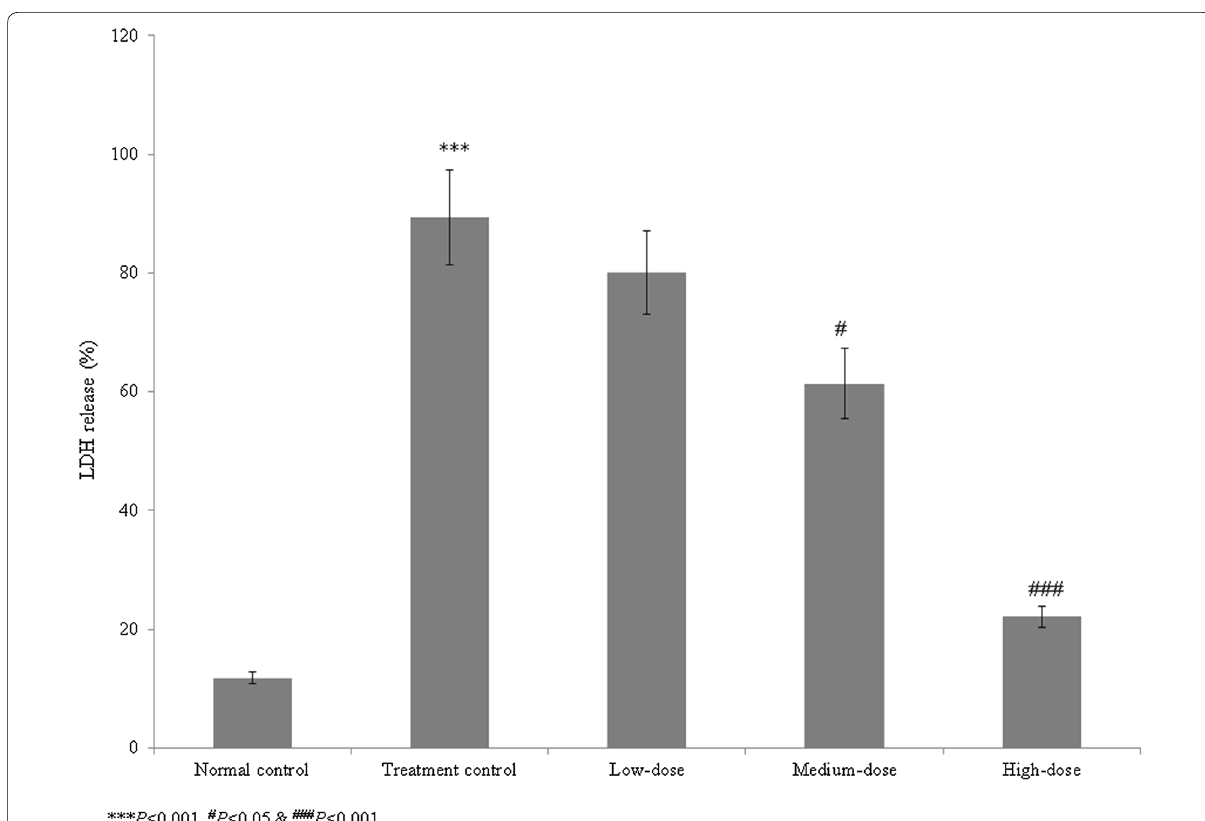
Fig. 2 Effect of catalpol on the lactate dehydrogenase (LDH) levels in human induced pluripotent stem cells with aconitine-induced cardiac arrhythmia. Catalpol treatment reduced the LDH levels by 10.4, 31.3, and 75.2% at concentrations of 1, 10, and 100 µM, respectively. *** P < 0.001 vs. Group I; # P < 0.05 and ### P < 0.001 vs. Group